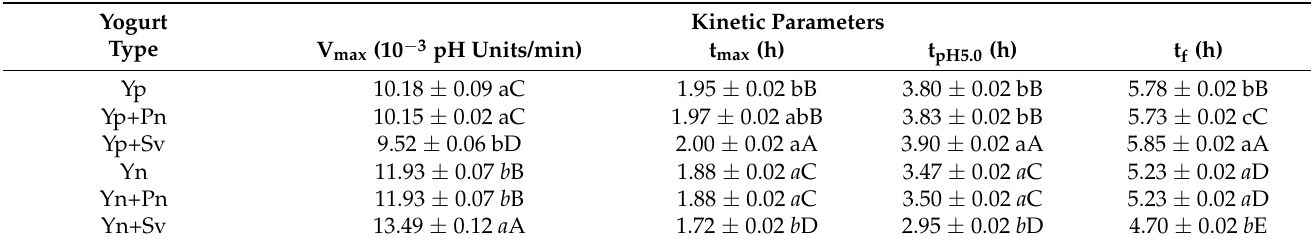
Table 1. Acidification kinetic parameters: V max —the maximum acidification rate; t max —the time taken to reach V max ; t pH5.0 —the time taken to reach pH 5.0; t f —the time to complete fermentation, of probiotic (Yp) and natural (Yn) yogurt with or without scCO 2 /H 2 O extracts from P. nigra (Pn) and S. viminalis (Sv) during fermentation *.